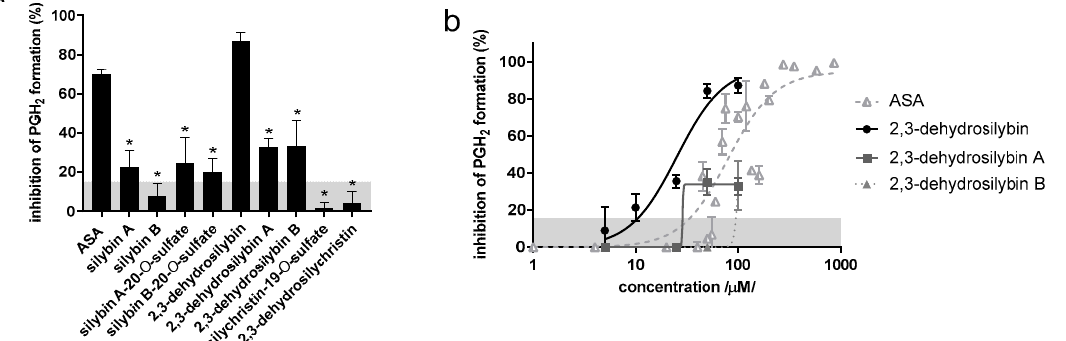
Figure 7. Effect of selected flavonolignans on ovine COX-1. ( a ): Comparison of tested substances and acetylsalicylic acid (ASA) at the final concentration of 100 µM, ( b ): Concentration-dependent curves of selected substances. * p <0.01 vs. ASA. Grey area indicates the error of the method. Data are expressed as mean ± SD.